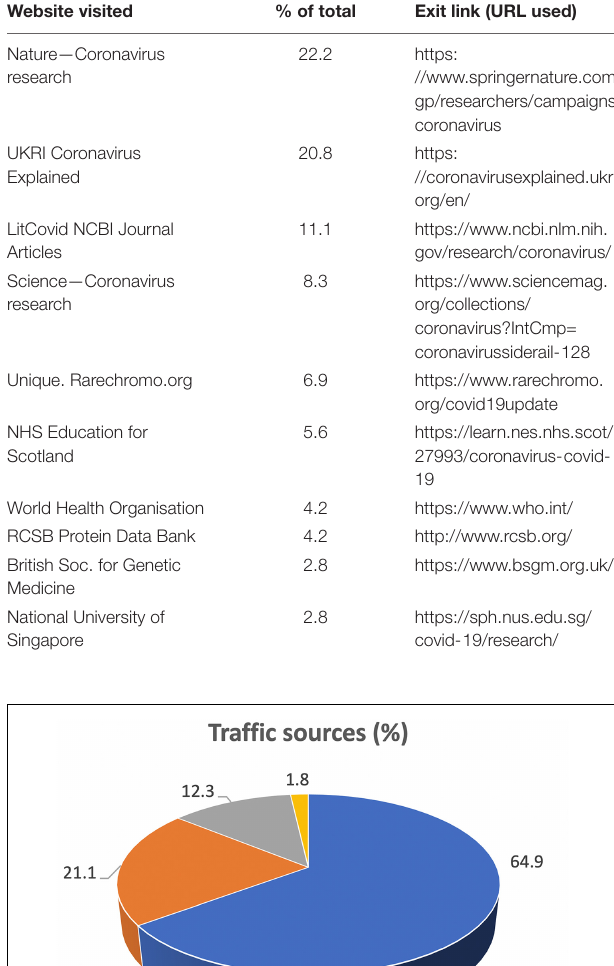
TABLE 3 | Countries or region of origin and respective proportions of website visits, in the first year since launch of the COVID-19 webpages. Country or region